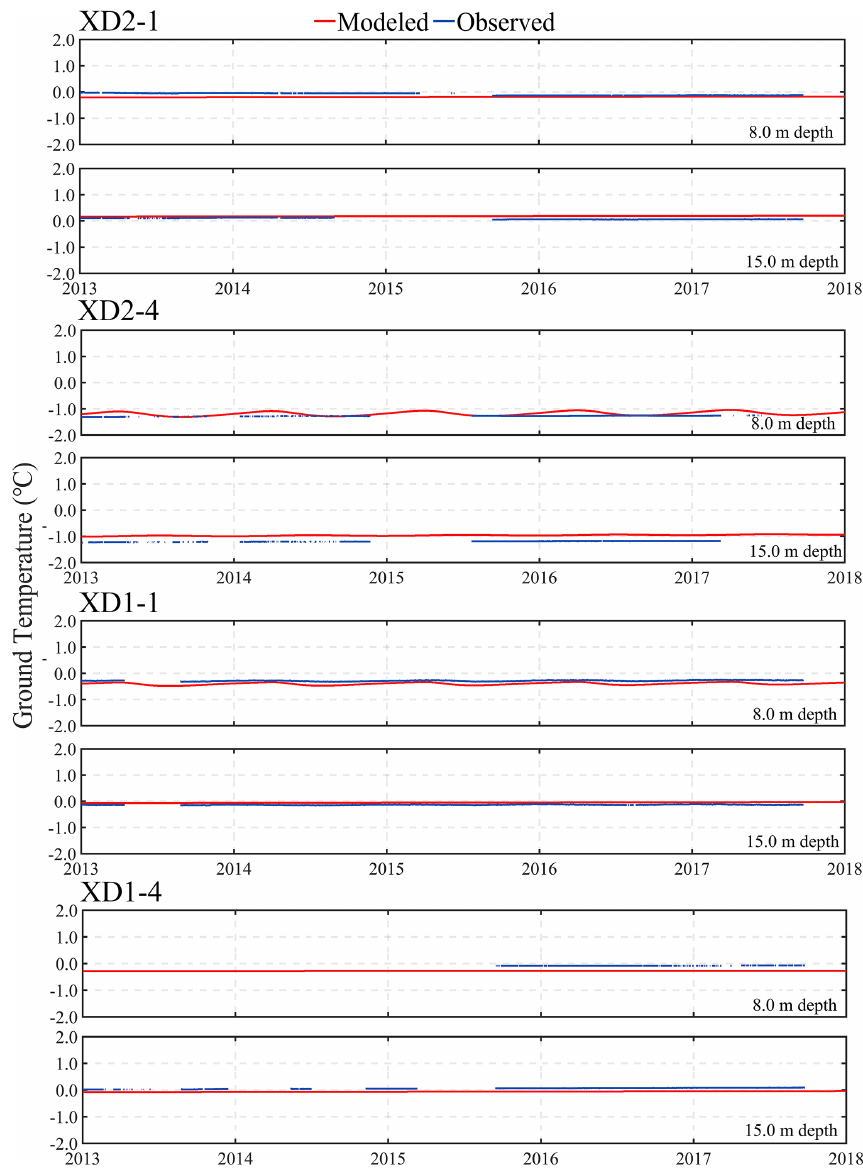
Figure A4. Same as Fig. 4 but for daily mean ground temperature at 8 and and